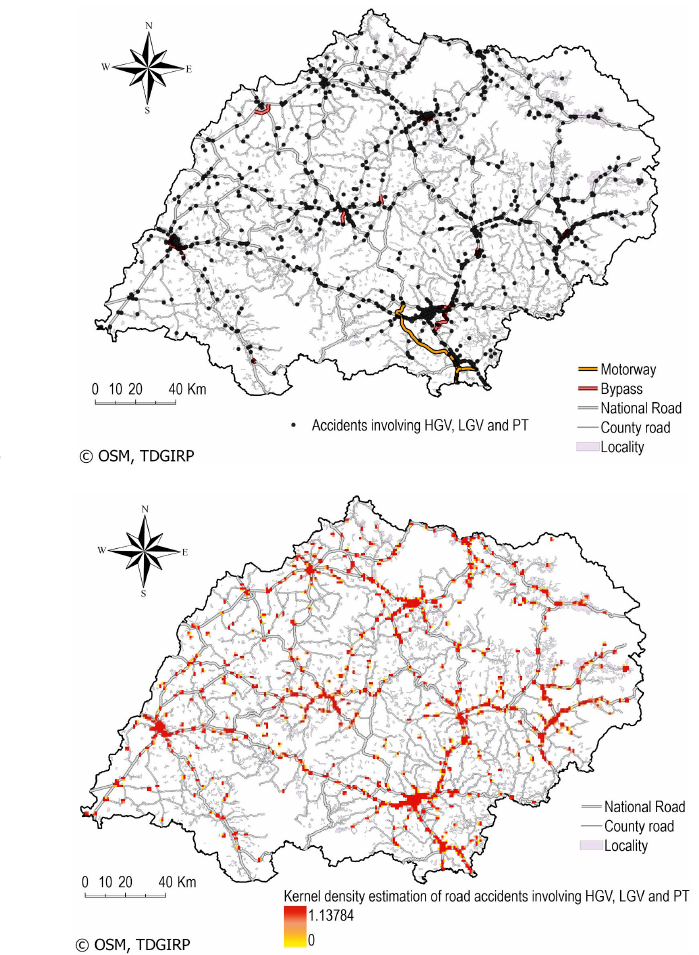
Figure 4. Accidents involving HGV, LGV and PT vehicles in the North-West Region of Romania: a) location on the main road network; b) kernel density